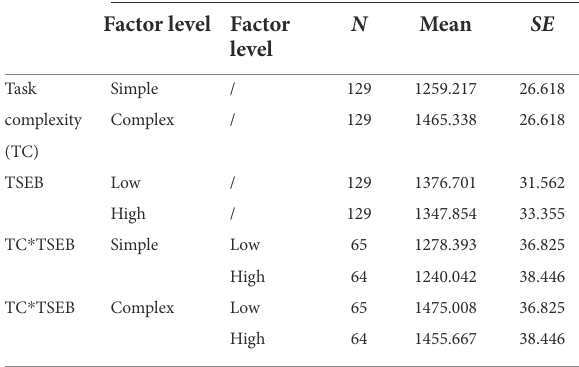
TABLE 2 Time-on-task—significant effect of task complexity.